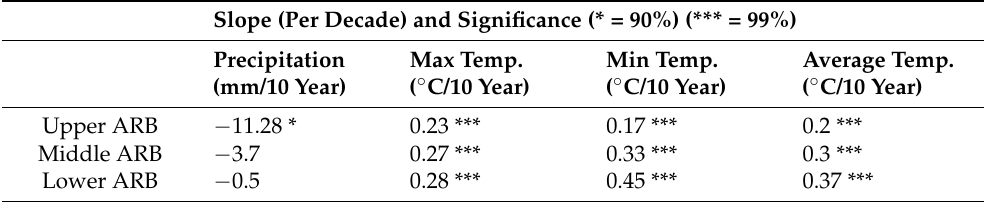
Table 2. MK trend slopes of climate data in the ARB between 1950 and 2019. Slope (Per Decade) and Significance (* = 90%) (*** = 99%)